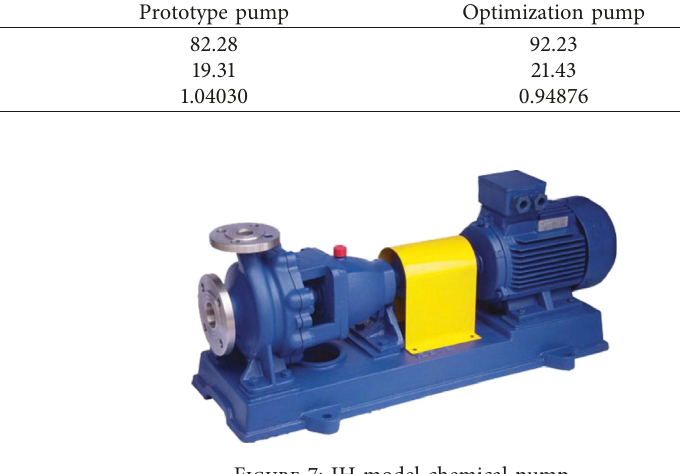
Figure 7: IH model chemical pump.